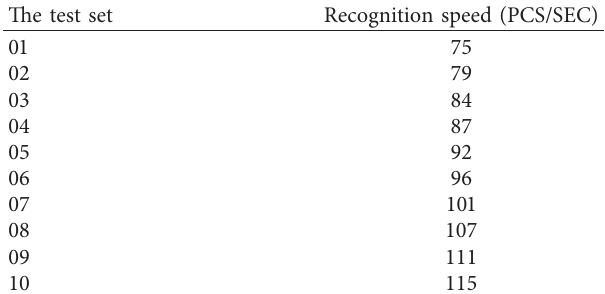
Table 5: Recognition speed of Method